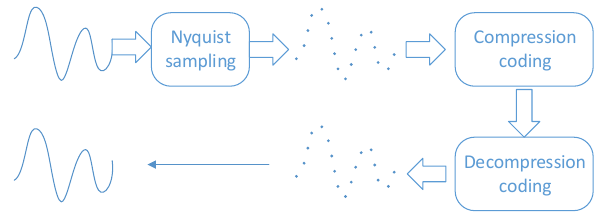
Figure 1. The traditional compression and decompression process.